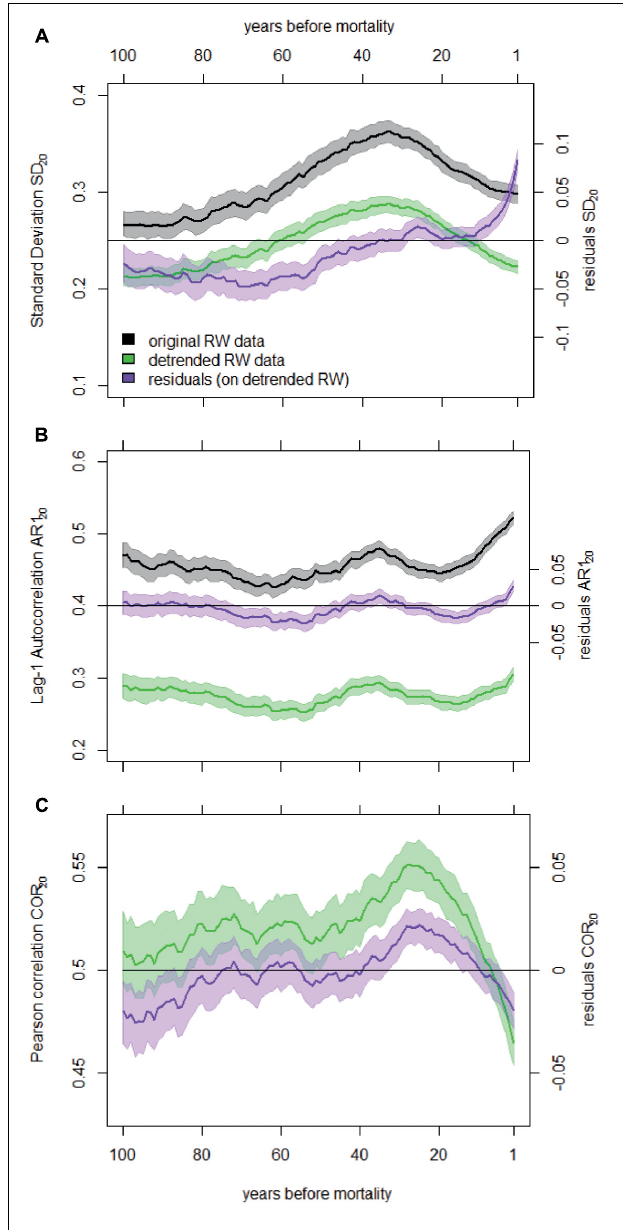
FIGURE 2 | Temporal change in SD 20 (A) , AR1 20 (B) , and COR 20 (C) before death averaged for all dying trees and calculated on the original and detrended RW data. We also show the temporal change in the residuals of the linear mixed-effects models fitted to these metrics (right y -axes). Shaded areas represent the 95% confidence intervals of the means. Note that COR20 values were not calculated on not-detrended RW